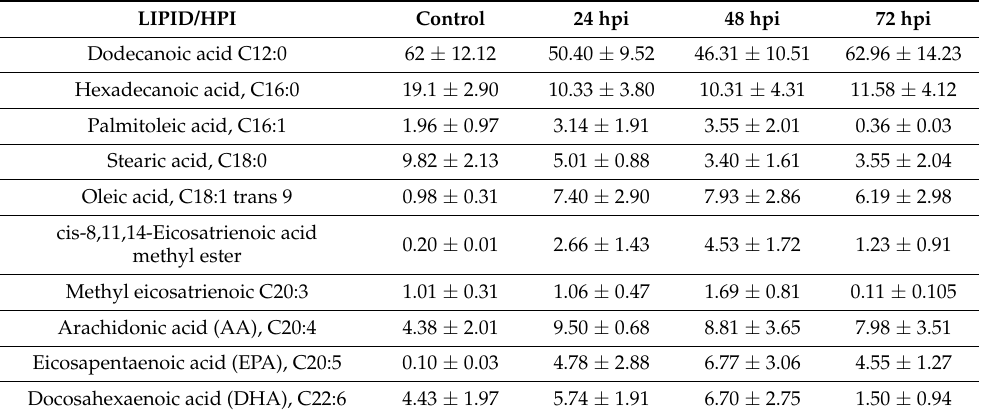
Table 1. Average composition of the fatty acid methyl esters of liver from IPNV infected salmon in each sample